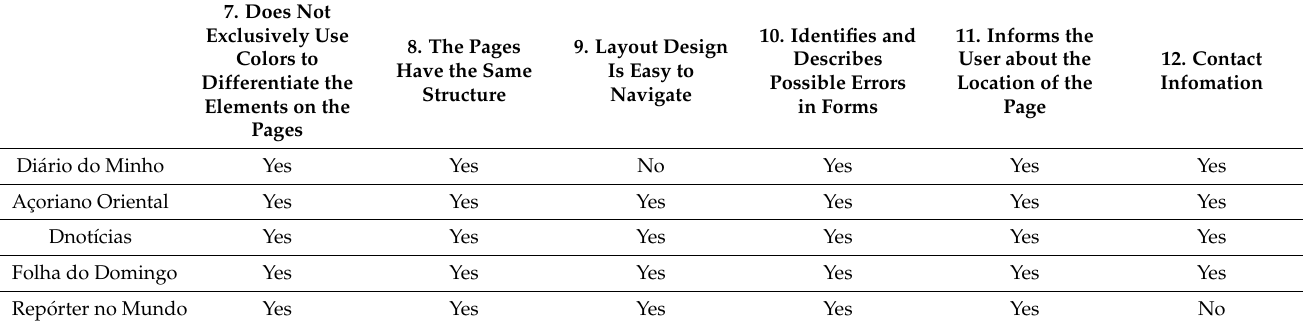
Table 4. Results of the evaluation of the design of Portuguese